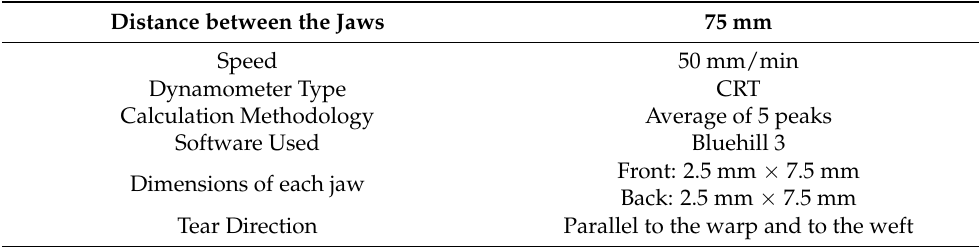
Table 1. Tearing strength experiment